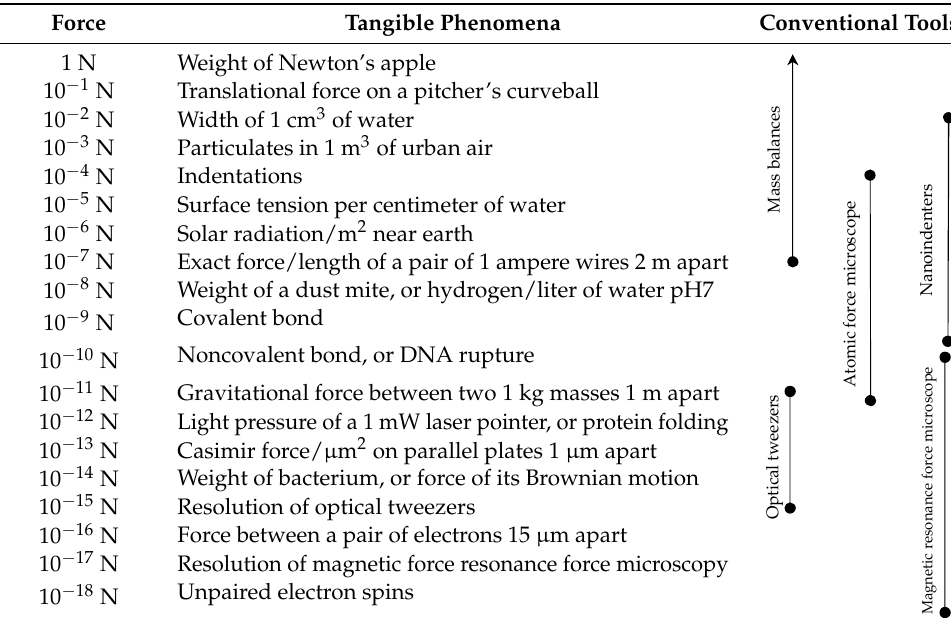
Table 1. Relative magnitudes of tangible forces.